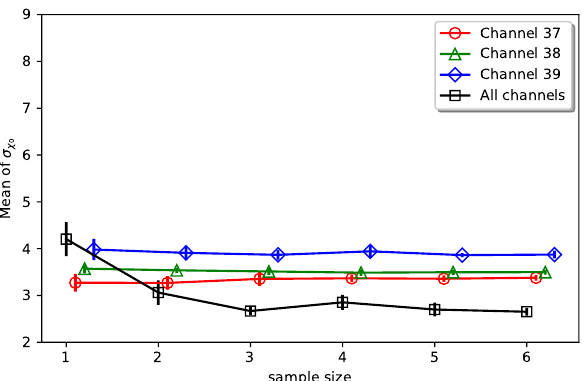
Figure 18. Mean of σ χ in the two-segment path loss models derived using the median of data 0 samples from six receivers. The vertical lines on each result data point in the figure represent the plus/minus standard deviation of σ χ over several repeated modeling processes using randomly 0 selected data samples.